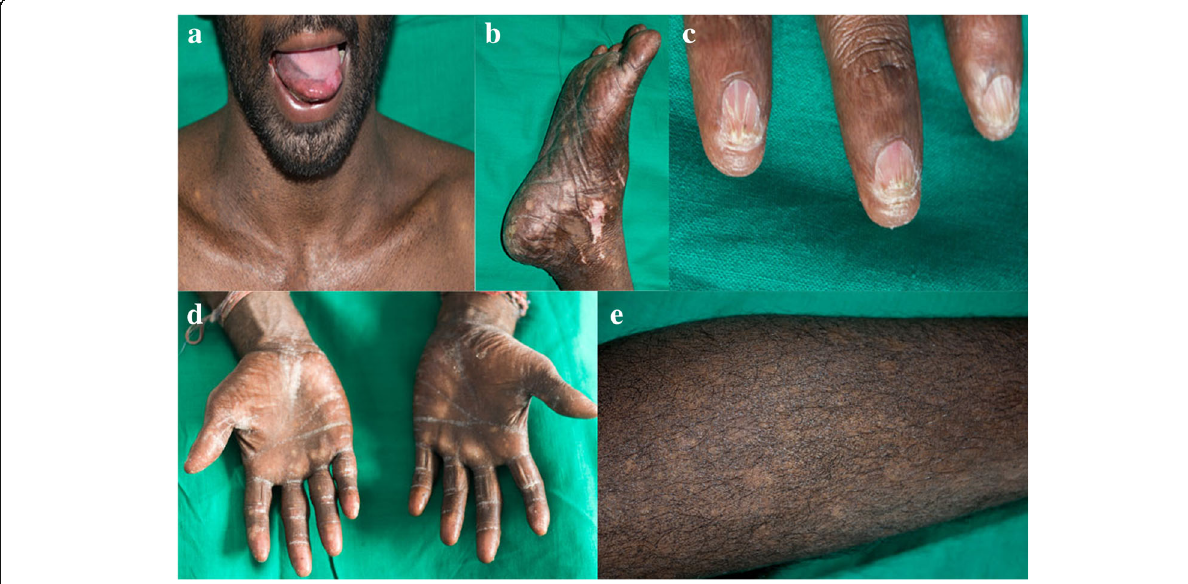
Fig. 1 Clinical features of the proband with dyskeratosis congenita showing: a oral leukoplakia, reticular hyperpigmentation of the neck and upper chest, b hypopigmented patches on the leg, c dysplastic finger nails, d adermatoglyphia, e lacy reticular hyperpigmentation of the lower